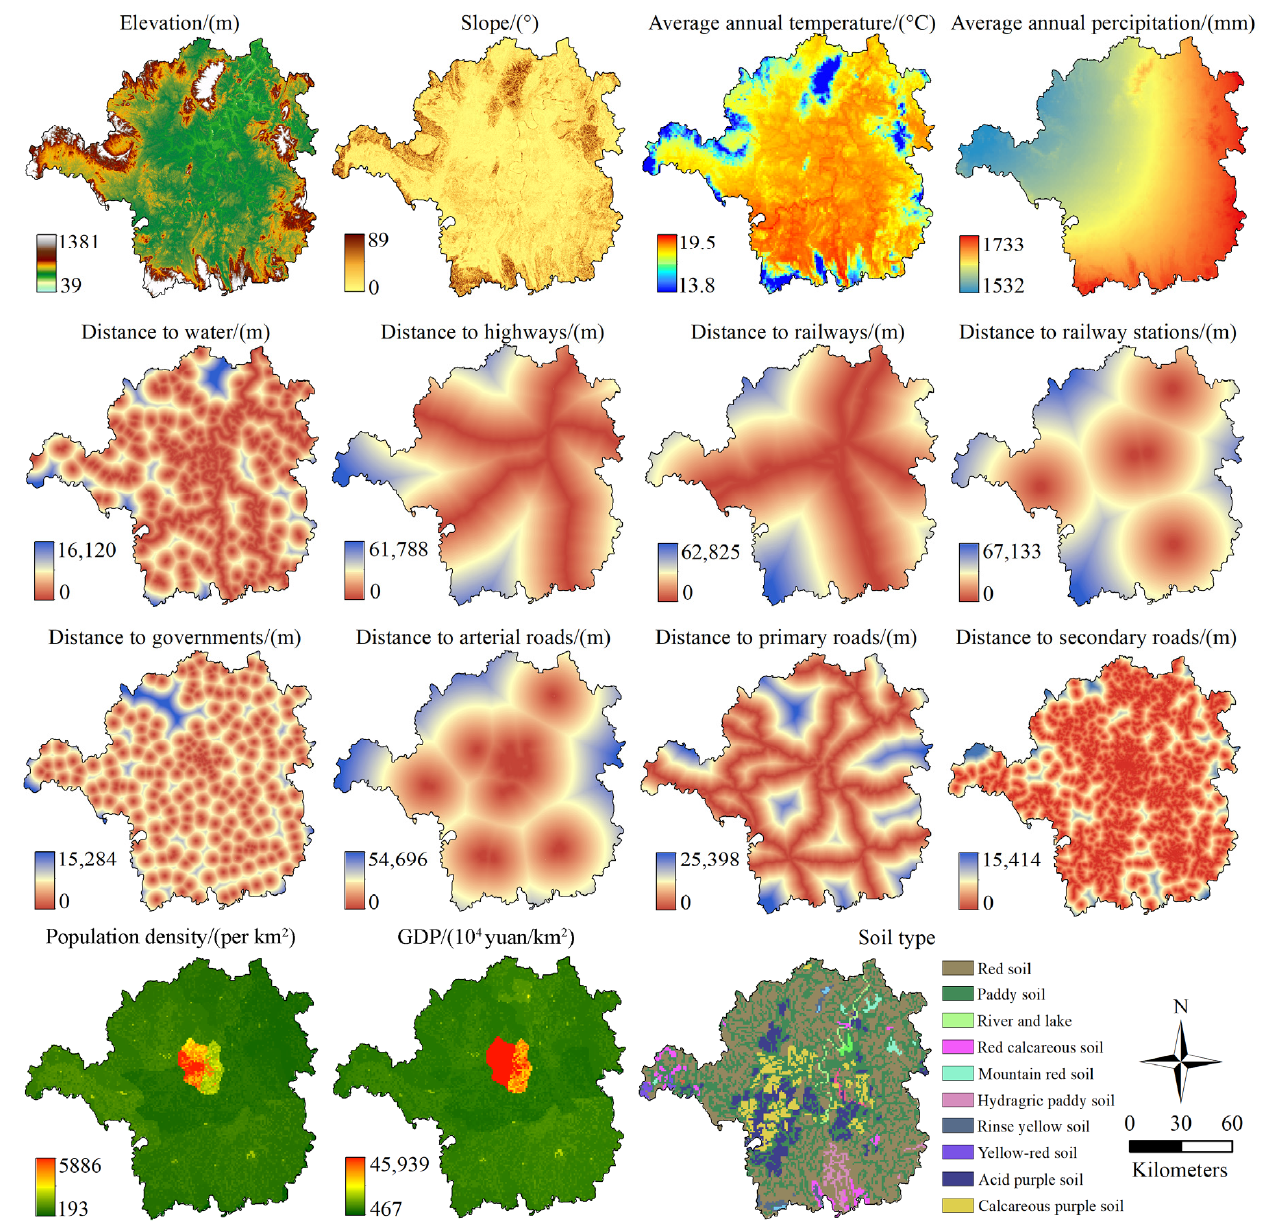
Figure 2. Spatial variables related to LULC change in